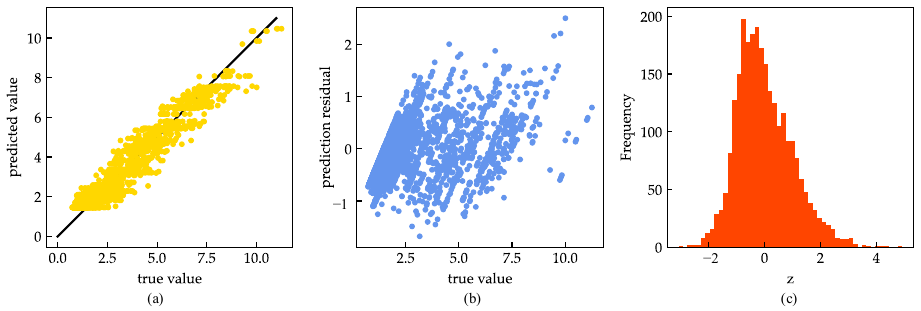
Figure 10. The prediction performance of AdaBoost: ( a ) The scatter plot between predicted value and true value; ( b ) The scatter plot between prediction residual and true value; ( c ) The histogram of z in the model.